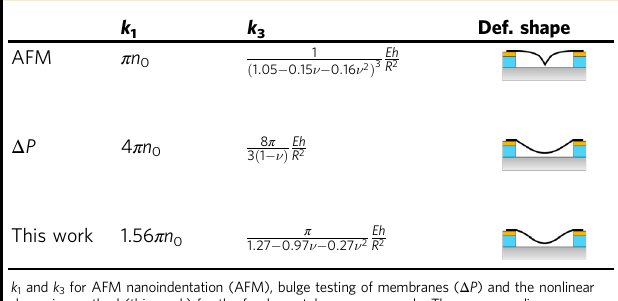
deformationshape,whichdeterminesthefunctionaldependenceof k 1 and k 3 ,isshownontheright